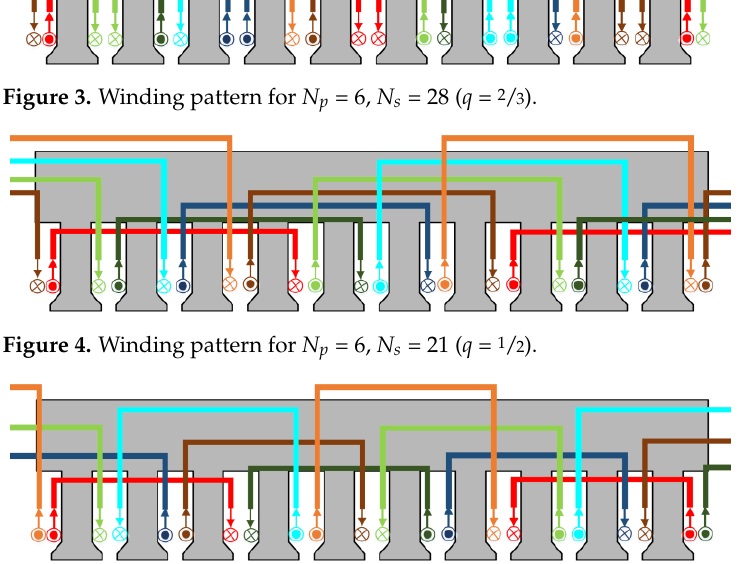
Figure 5. Winding pattern for N P = 6, N S = 14 (q = ⅓).